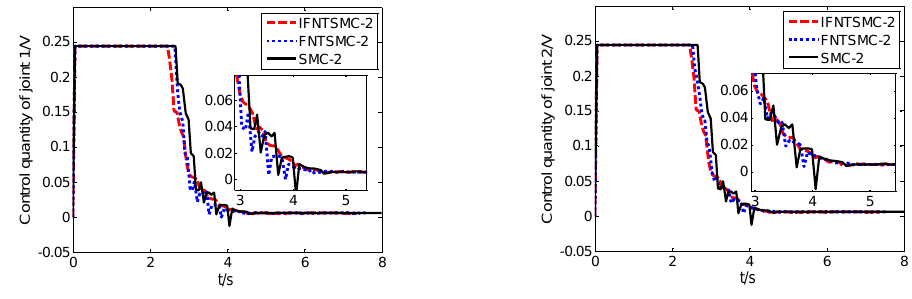
Figure 9. Control quantity of the motor in the